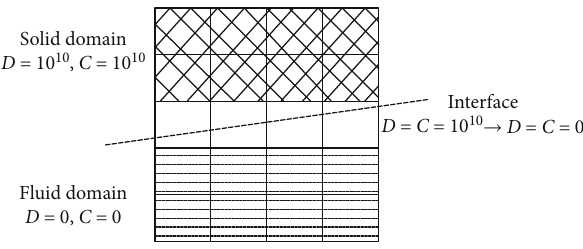
Figure 3: Resistance coe ffi cient in the computational domain.